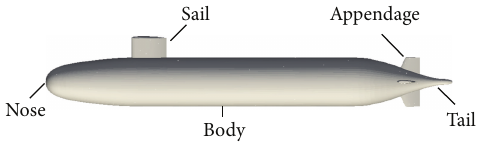
Figure 1: DARPA submarine model.